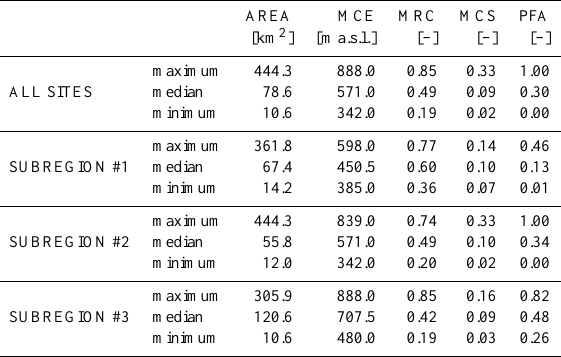
Table 1. The basic catchments characteristics used in this study. ALL SITES = all sites included (72 sites with no regional delin- eation), SUBREGION #1 = Innviertel + Hausruckviertel (24 sites), SUBREGION #2 = Traunviertel + Flysh (22 sites) and SUBRE- GION #3 = Mühlviertel + Waldviertel (26 sites). AREA –